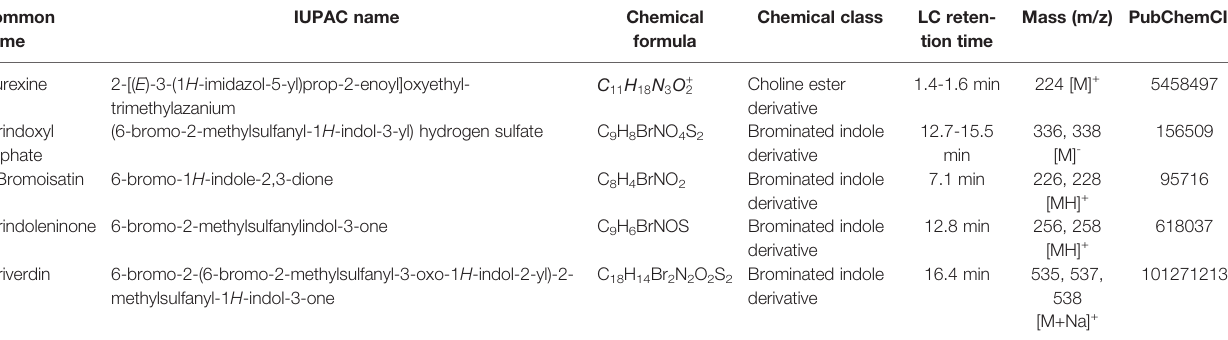
TABLE 2 | Details of the secondary metabolites analyzed in the extracts of Dicathais orbita using liquid chromatography (LC) - Mass spectrometry